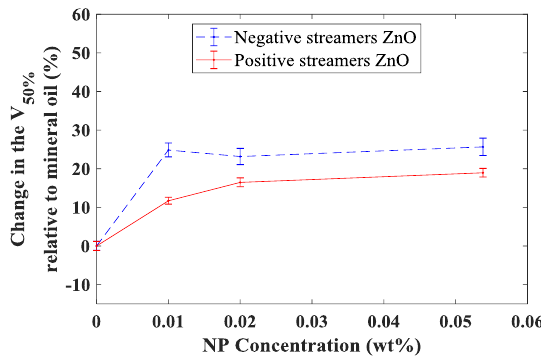
Figure 10. Change in 𝑉 50% of ZnO nanofluids relative to mineral oil as a function of mass fraction 𝑤 𝑖 .